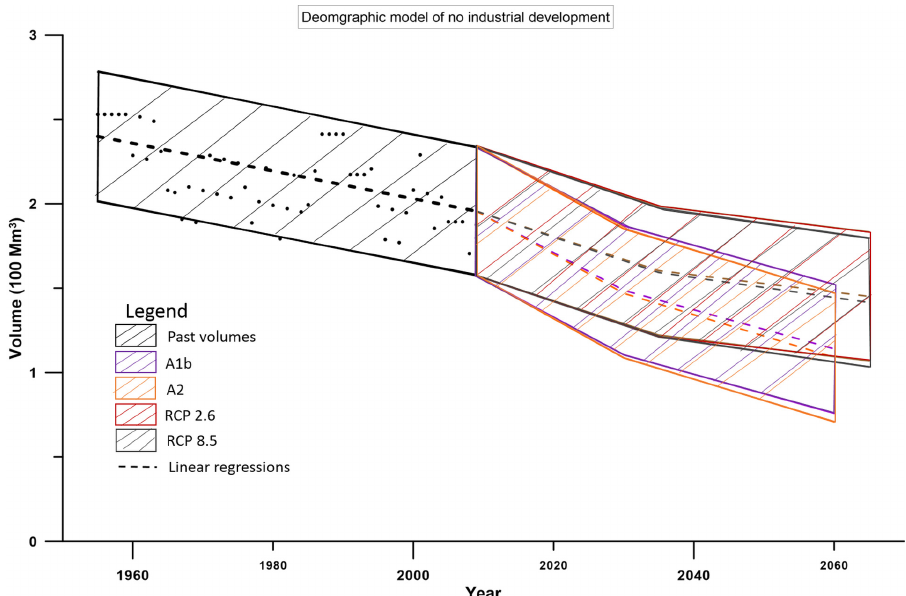
Figure 9. Graph, with the shaded areas representing the effective volume of Shela aquifer and projected volumes for all four climate change scenarios, as well as the uncertainties for the demographic model without the port (“no industrial